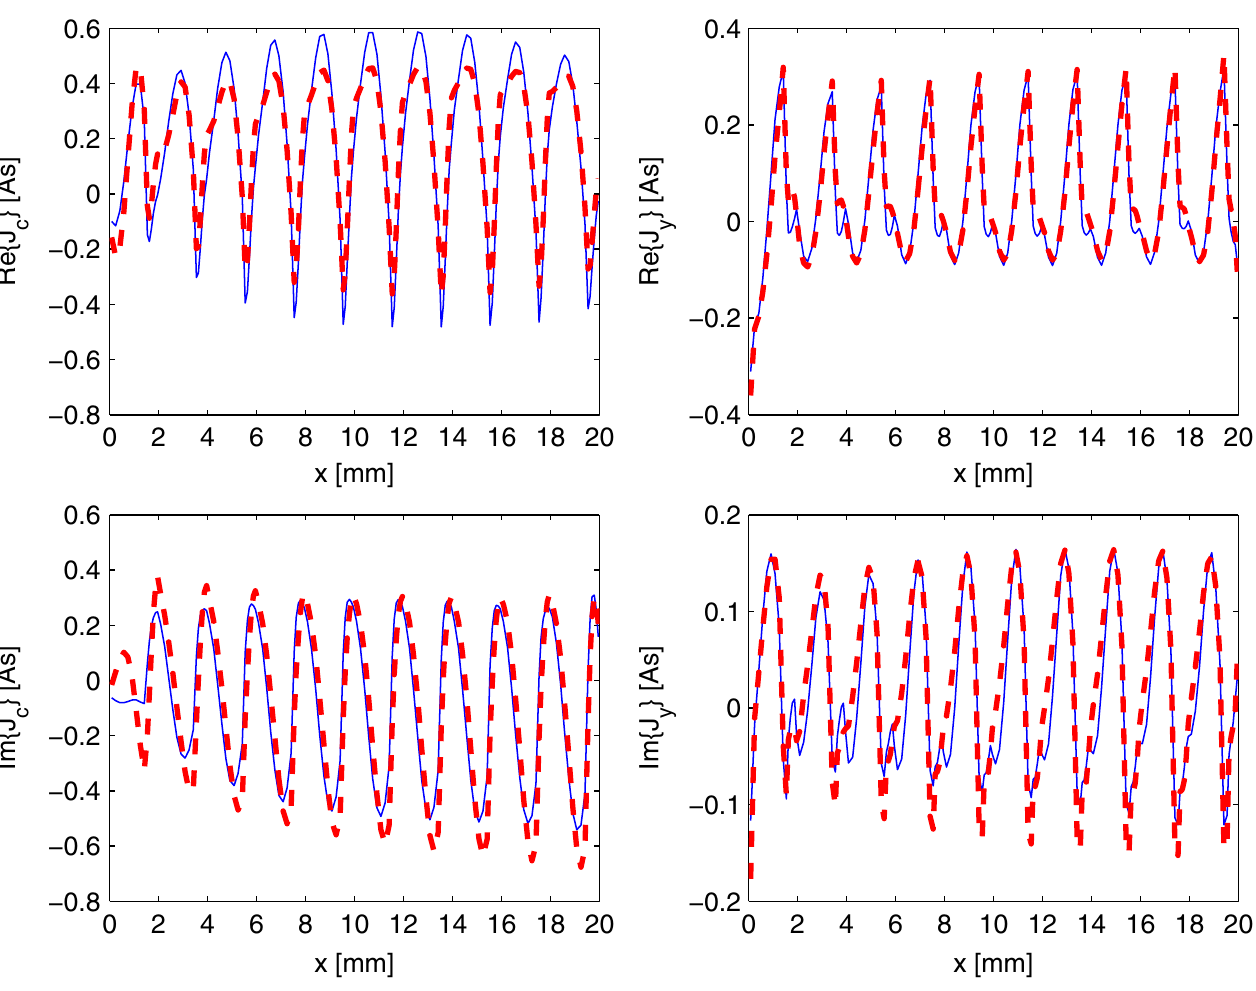
FIG. 5. (Color) Projection by Eq. (17) of the surface currents shown in Fig. 3 for (cid:4) ¼ 70 (cid:7) vs the grating length (solid lines). These currents are compared to the case of an infinitely wide grating [30] (dashed lines).